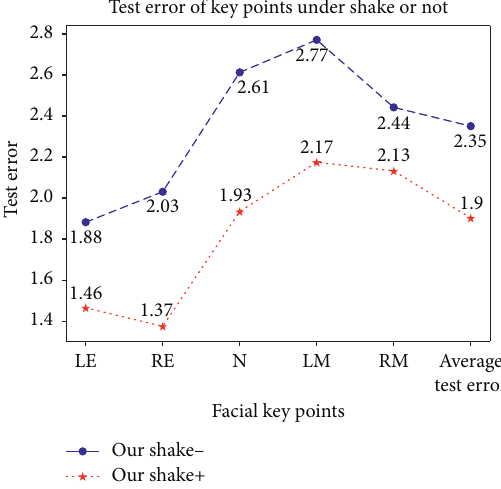
Figure 6: Test error graph of key points under shake or not.